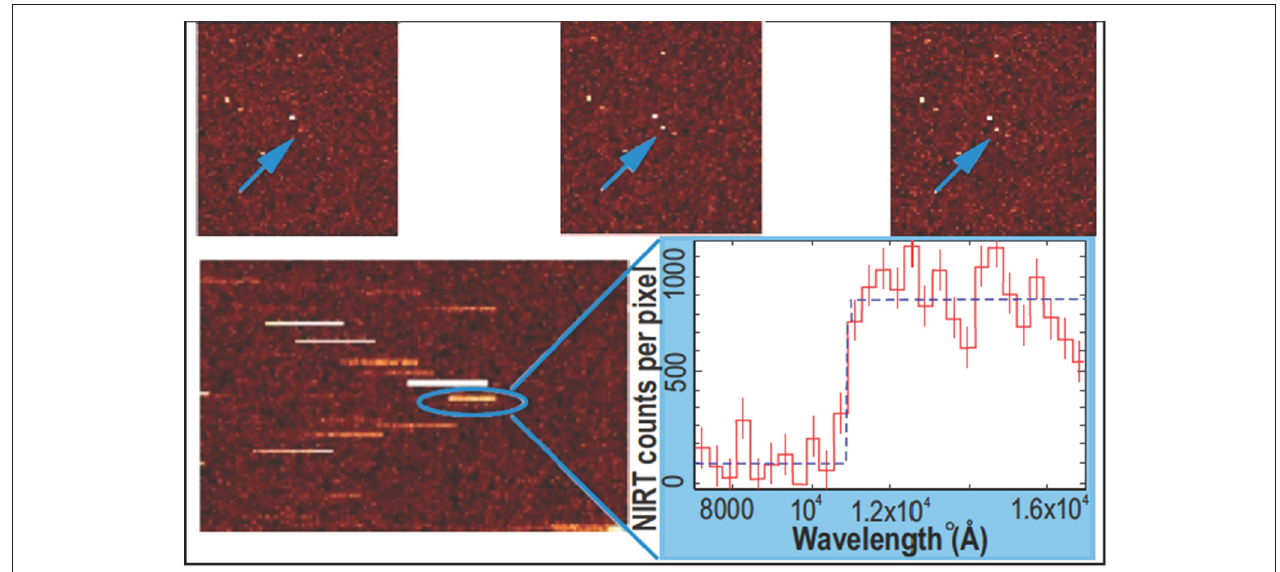
FIGURE 1 | ATO-NIRT images will identify young, variable afterglows (upper 3 images), and objective prism exposures (lower images) will yield redshifts via Ly-break at z ≥ 5. Once high- z is ascertained, R ∼ 1,000 NIRT spectra will be taken.